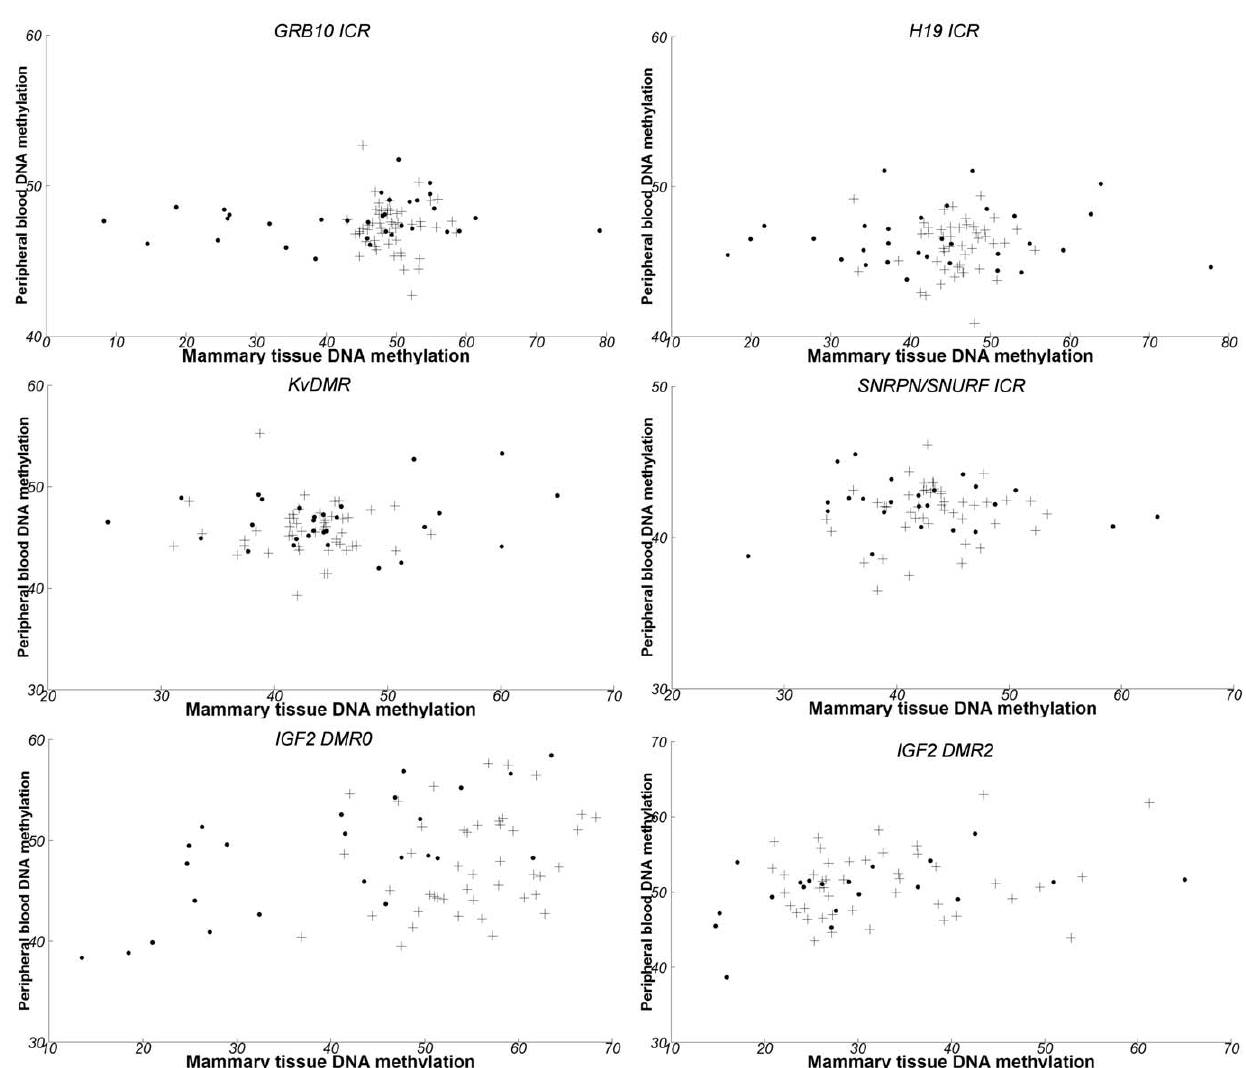
Figure 2. Comparisons between blood and mammary tissue DNA methylation. Axes correspond to percent-methylation observed in blood and mammary tissue, respectively. Crosses correspond to non-cancerous cases, and circles to invasive